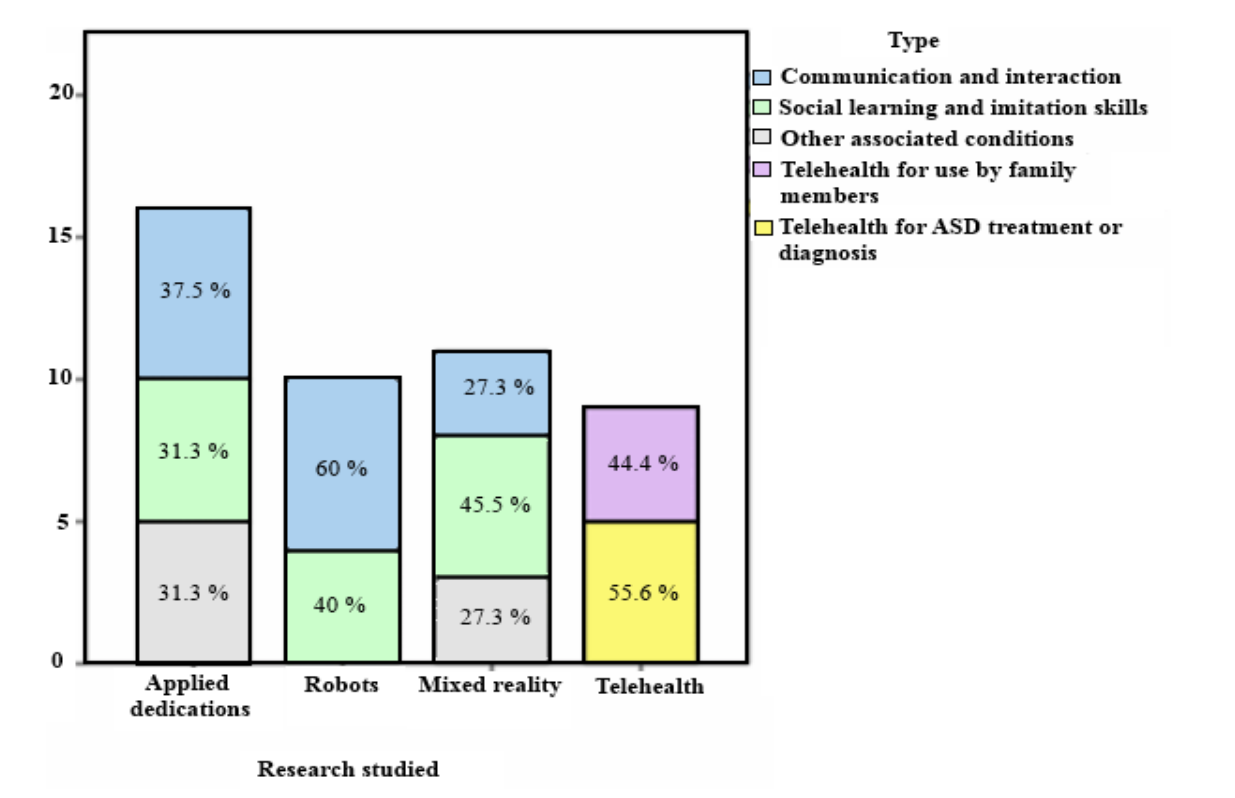
Figure 7. Analysis by technology and area being